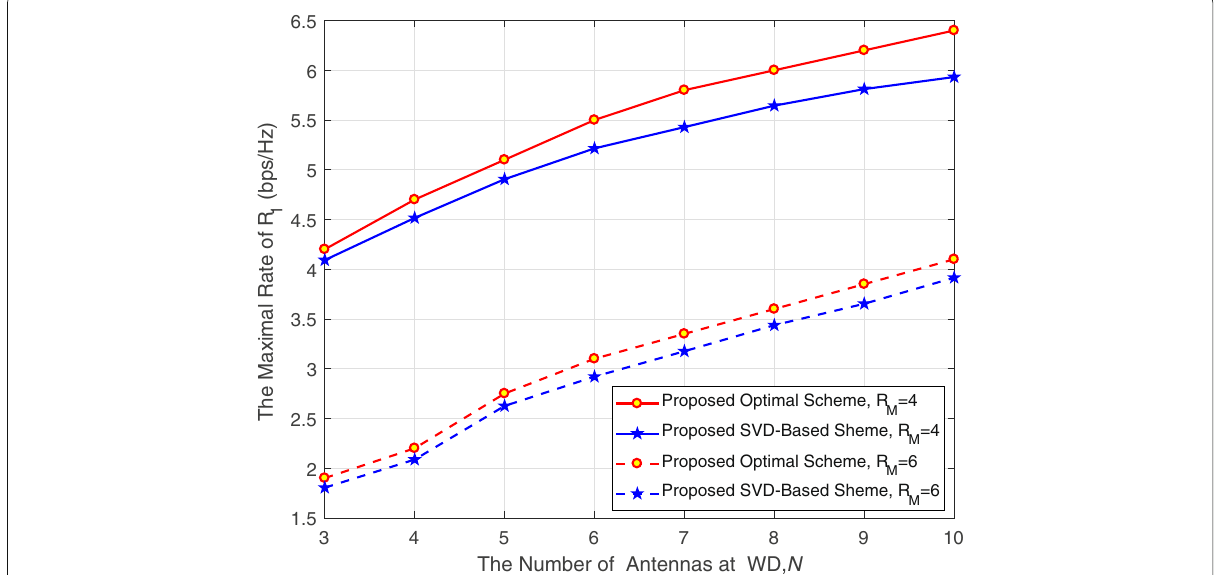
Fig. 3 Simulation 2. The maximal rate of R 1 versus the number of antennas at WD for different schemes with P = 25